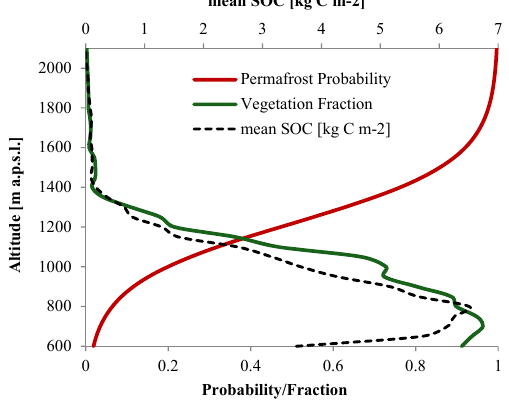
Figure 5. Fraction of vegetation cover and probability for per- mafrost presence in relation to altitude in Tarfala Valley, including the mean SOC storage per altitude (calculated in 50m altitudinal intervals). The permafrost probability is based on the BTS mea- surements and a logistic regression with the altitude as single inde- pendent variable. The vegetation fraction is based on the altitudi- nal distribution of vegetated classes in the land cover classification. Slightly lower SOC values at elevations below 700m are related to exposed streambeds in the Tarfala river alluvial